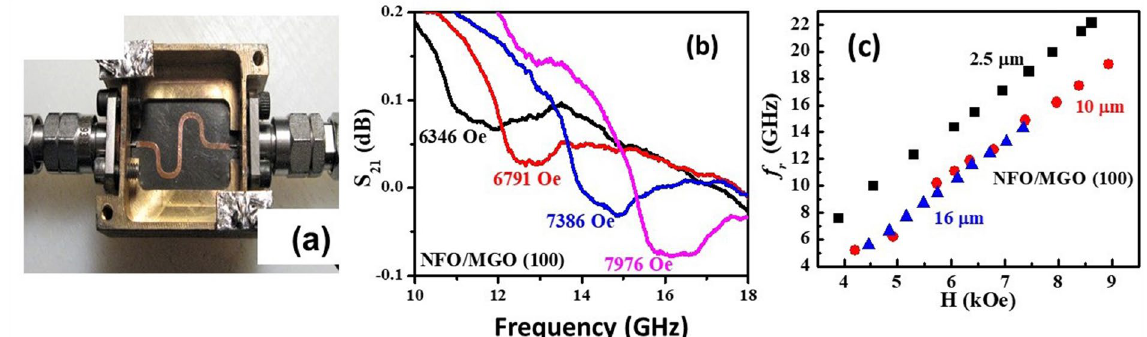
Figure 5. ( a ) Coplanar waveguide microwave excitation structure used for FMR measurements. ( b ) Profiles of S 21 amplitude vs frequency for a series of magnetic fields perpendicular to the film plane for NFO film with thickness of 10 μm on (100) MGO. ( c ) Resonance frequency f r obtained from profiles as a function of H for NFO films with thickness of 2.5, 10 and 16 μm on (100)